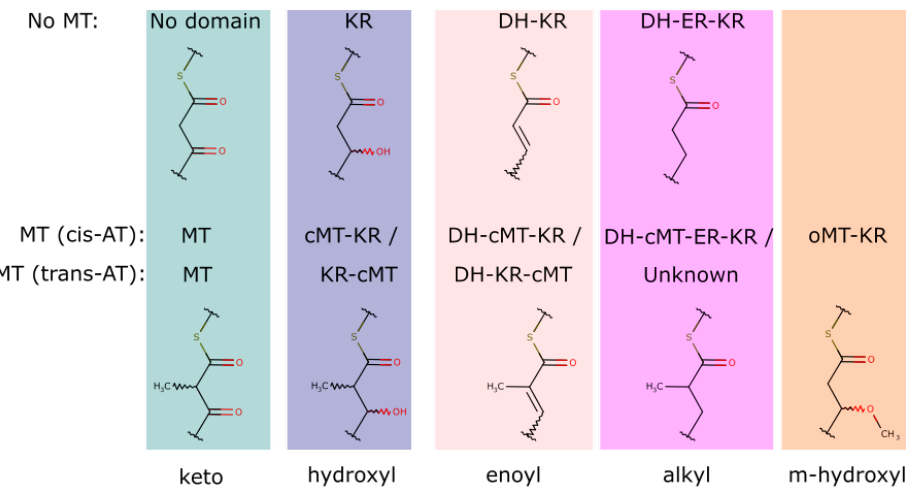
Figure 4. Reduction and methyltransferase domain combinations for described PKS modules. The resulting building block modifications are depicted below the domain combination. The methyltransferase position for cis and trans-AT modules are shown. Each domain combination (X) is encapsulated such as KS-(AT)-X-ACP. The figure is based on the article by Nguyen et al. [18].